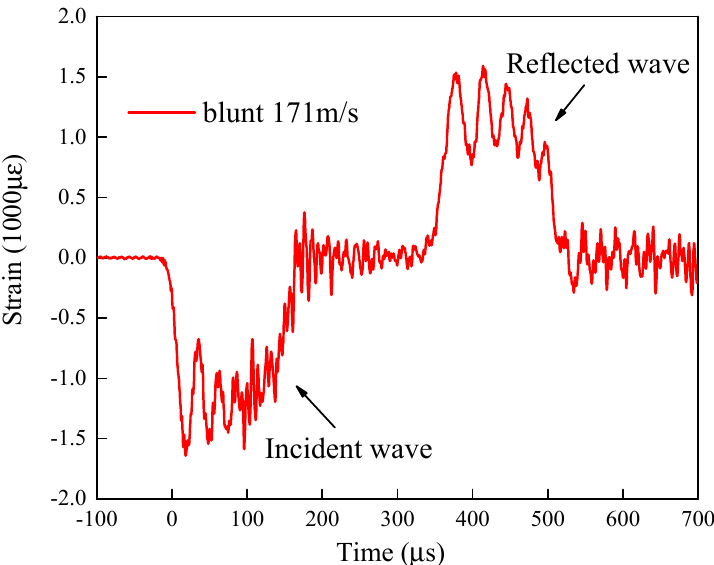
Figure 14. Strain-time signal measured on the Hopkinson bar (blunt projectile with 171 m/s impact velocity).